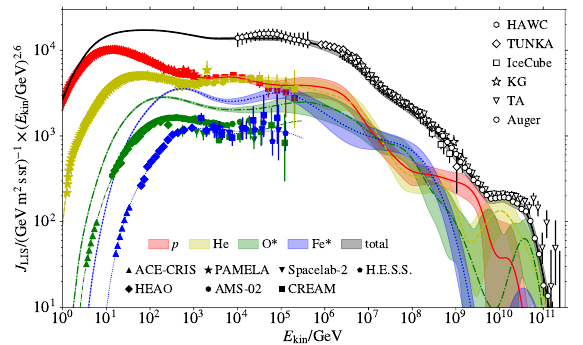
Figure 4. Global spline fit (GSF) of cosmic-ray data (lines) and energy-scale adjusted data (points) [38]. The GSF treats energy- scale o ff sets as soft-constrained free parameters and produces energy-scale adjustment factors as a fit result.